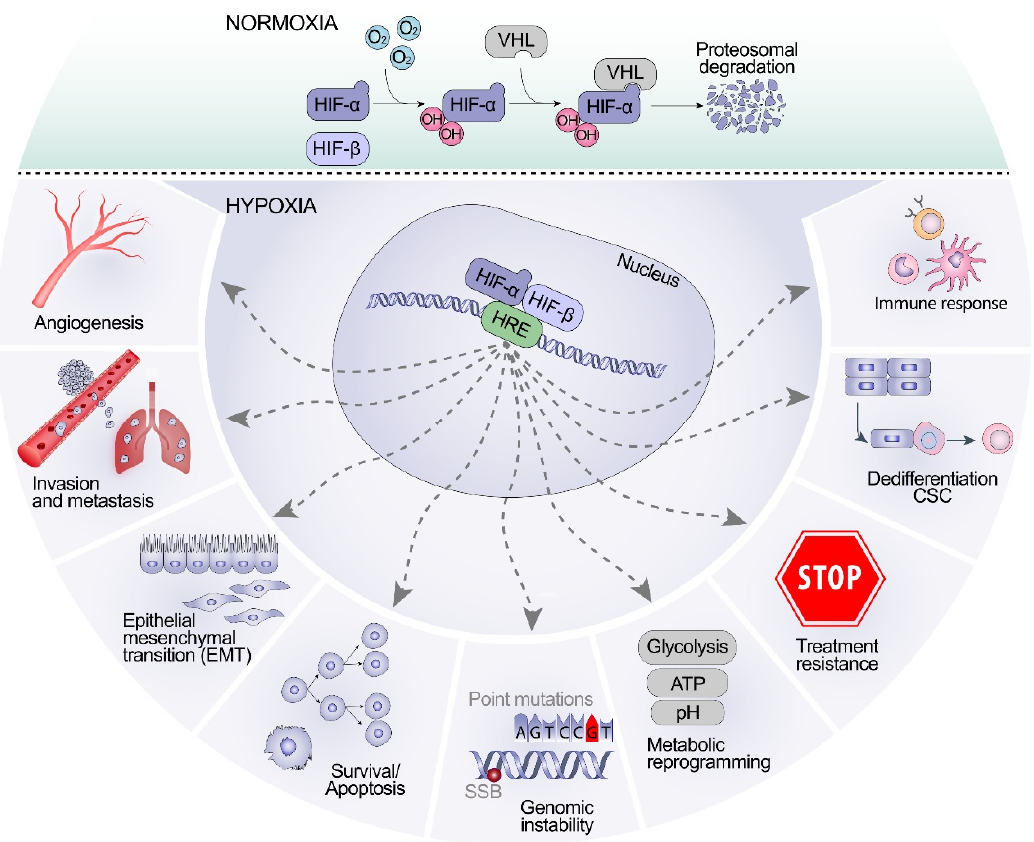
Figure 3. A graphical illustration of normoxia and hypoxia. HIF- α is degraded by VHL under normoxic conditions. Under hypoxic conditions, HIF- α is stabilized and induces the expression of target genes that are associated with tumor promotion. SSB (single-strand break ), CSC (cancer stem cell). Adapted from [79]. cell). Adapted from